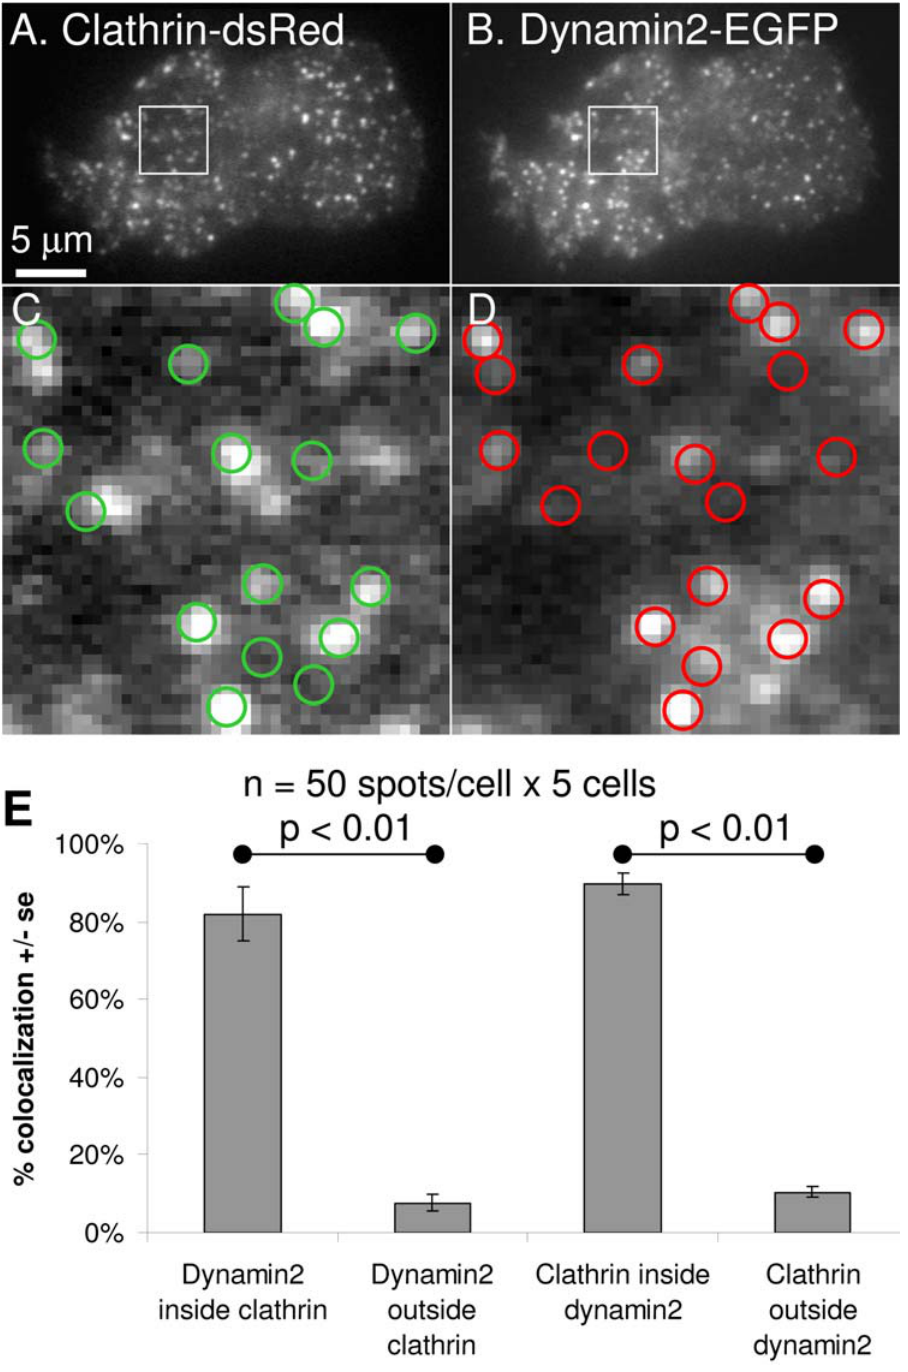
Figure 2. Co-localization of clathrin and dynamin2 in PC12 cells. PC12 cells co-transfected with clathrin-dsRed (A,C) and dynamin2-EGFP (B,D) were imaged by TIR-FM. Regions drawn around clathrin spots (A) were transferred to dynamin2 images (red circles in D). Regions drawn around dynamin2 spots (B) were transferred to clathrin images (green circles in C). 250 spots per group were evaluated to determine if clathrin and dynamin2 co-localise (E). Dynamin2 corresponding to clathrin spots is significantly higher than dynamin1 outside clathrin spots. Clathrin at sites of dynamin2 spots is significantly higher than dynamin1 outside clathrin spots.